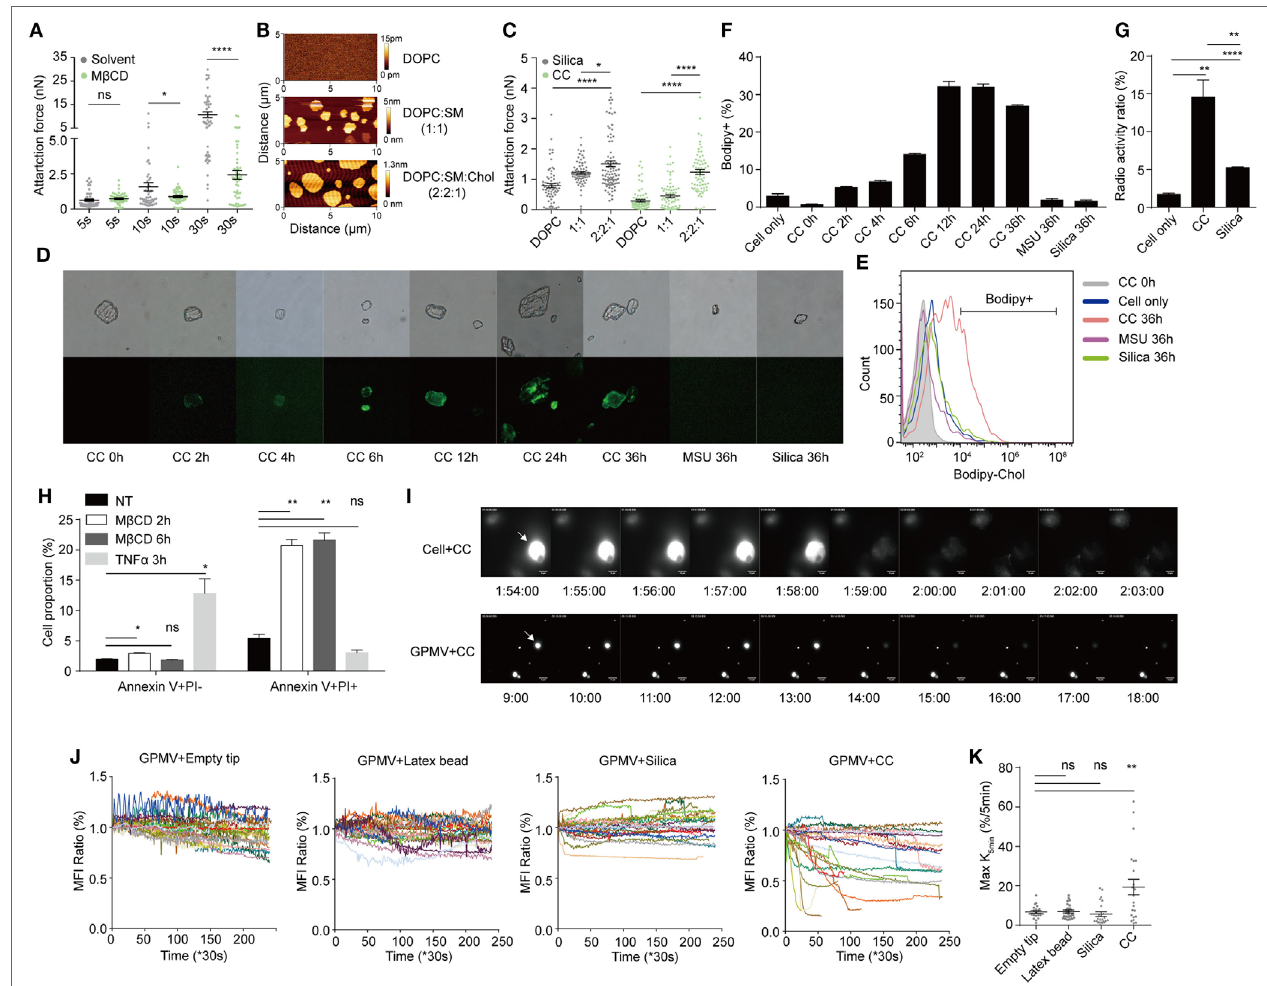
FigUre 4 | Cholesterol crystals (CC) extract cholesterol from membrane thus induce signaling free membrane rupture. (a) BMDM membrane cholesterol was depleted by M β CD (4 mg/ml) incubation in serum-free medium for 0.5 h. The attraction force between CC and cells after different contact times was measured by AFM. N = 3. (B) Lipid bilayers with or without cholesterol/SM were produced. The surface of the bilayer was scanned by JPK NanoWizard. The shade of color indicates the height of the surface. (c) The attraction forces between crystal and lipid bilayers were measured by AFM with a contact time of 30 s. N = 3. (D) BMDM were labeled with Bodipy-cholesterol delivered by M β CD and treated with CC (100 µg/ml), MSU (100 µg/ml), or silica (80 µg/ml). After different lengths of incubation at 37°C, cells were lysed and the fluorescence on collected crystals were observed with fluorescence microscope. (e) The collected crystals in (D) were analyzed with FACS. (F) The bar graphs of Bodipy-positive crystals in (e) . n = 3. N = 6. (g) BMDM was labeled with cholesterol-[H 3 ] and treated with CC (100 µg/ml), silica (100 µg/ml). 24 h later, cells were lysed and the radioactivity of the collected crystals was detected. n = 4. N = 3. (h) BMDM were treated with M β CD (8 mg/ml) for 2 or 6 h or with TNF α plus CHX for 3 h. Cells were collected and stained with Annexin V and PI. Samples were analyzed by FACS. n = 4. N = 4. (i) Upper: A GFP-expressing BMDM was contacted by a CC constantly. GFP fluorescence of the cell was imaged every 20 s with a 488-nm laser in FITC channel. The pictures show the cell fluorescence around the moment of “explosion.” Numbers below the pictures indicate the time since crystal contact. Lower: a GFP-containing giant plasma-membrane vesicle (GPMV) was contacted by a CC constantly. The rest was identical to the upper panel. The white arrow indicates the crystal-contacted cell or GPMV. (J) Mean fluorescence intensity of GPMV and background was measured with ImageJ. Fold change (compared with initial value) curve of MFI GPMV / MFI Background during CC and other crystal contact was calculated. Each curve represents a crystal-contacted vesicle. (K) Maximum reduction of normalized MFI GPMV / MFI Background within 5 min during the contact was manually identified and